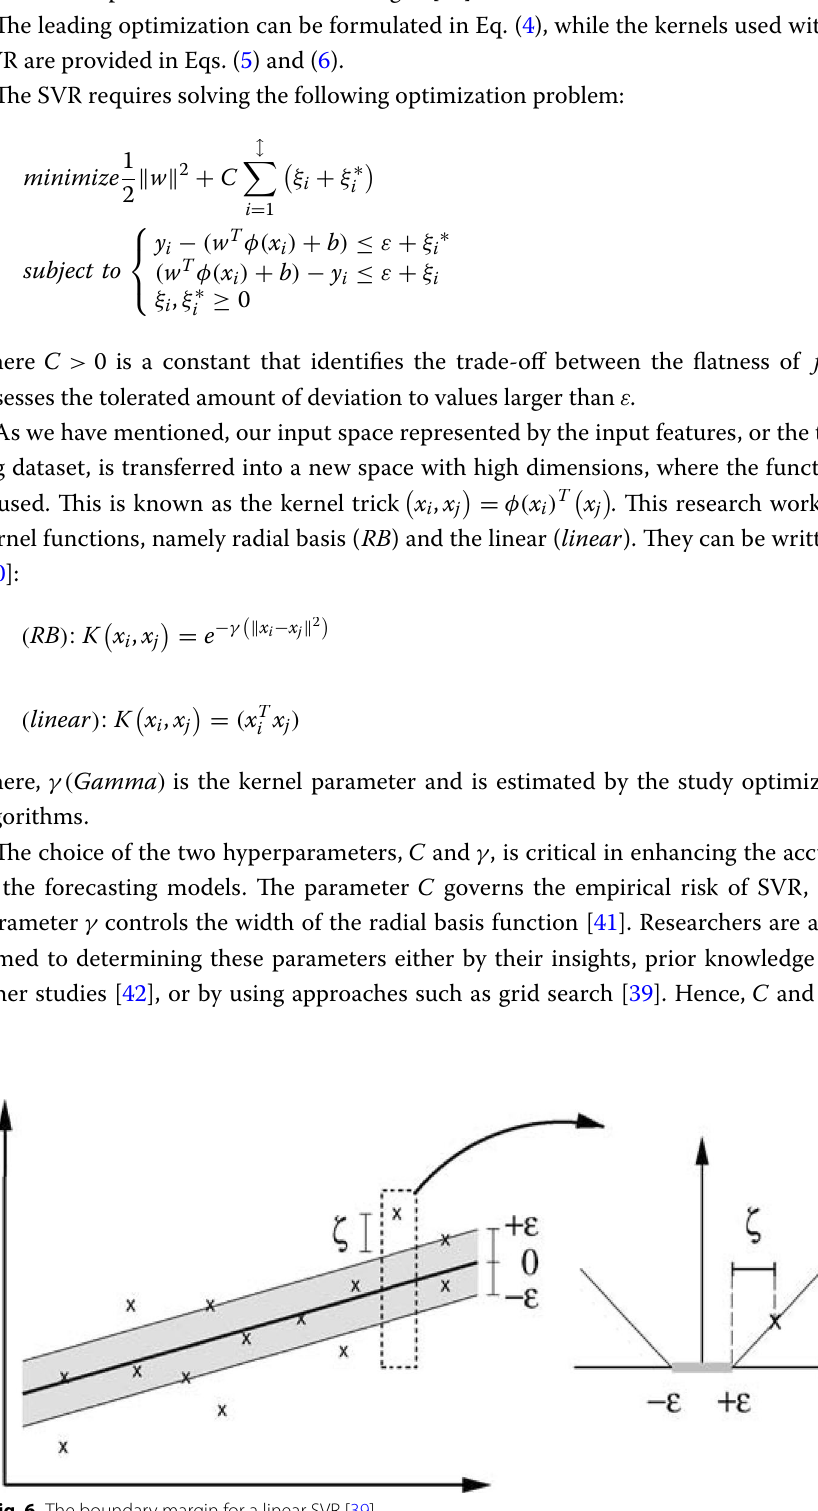
Fig. 6 The boundary margin for a linear SVR